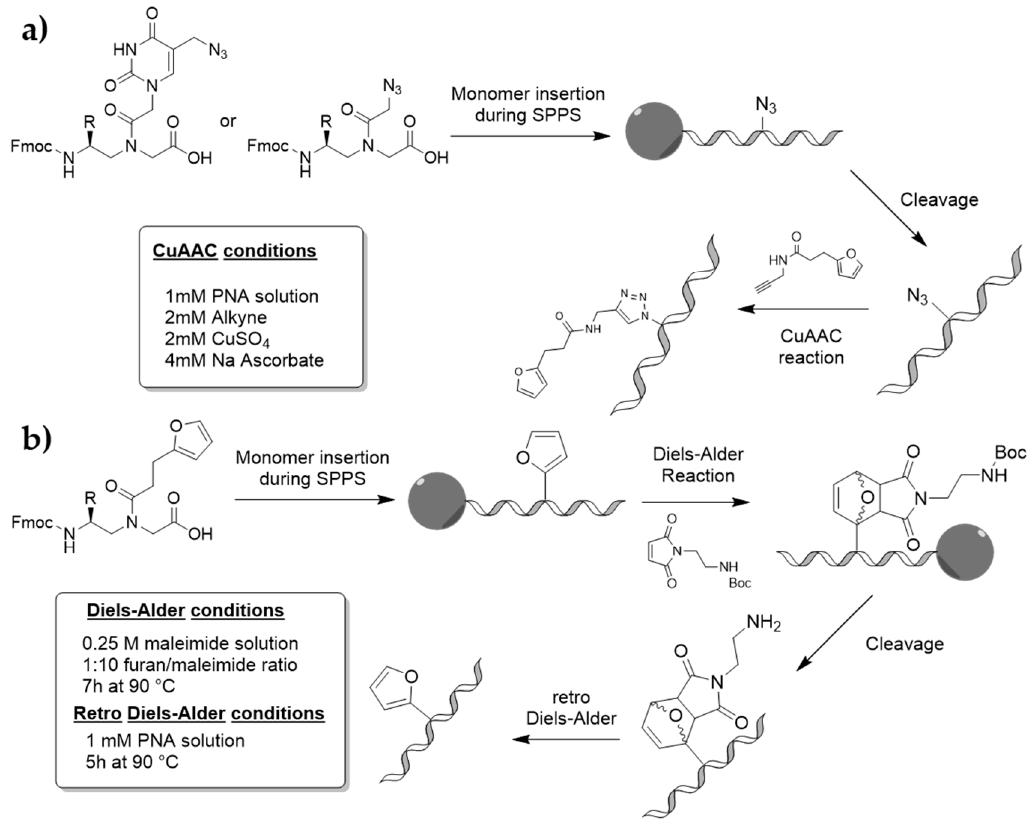
Figure 2. ( a ) General protocol for the synthesis of PNA 4 – 9 ; ( b ) general protocol for the synthesis of